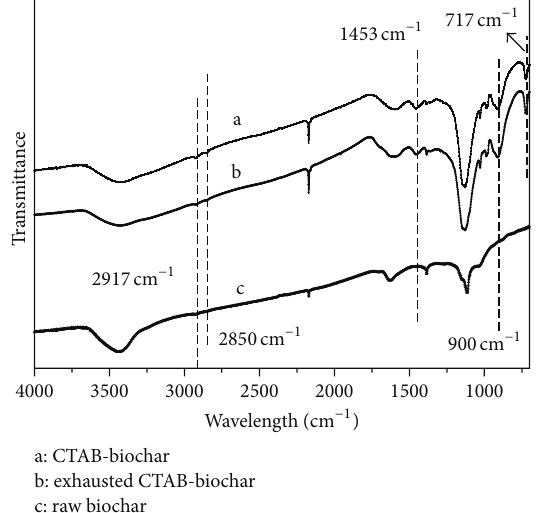
Figure 3: Effect of charge property of dye on the adsorption by CTAB-modified biochar. The concentration for both ORII and MB was 8mg/L, sorbent dosage